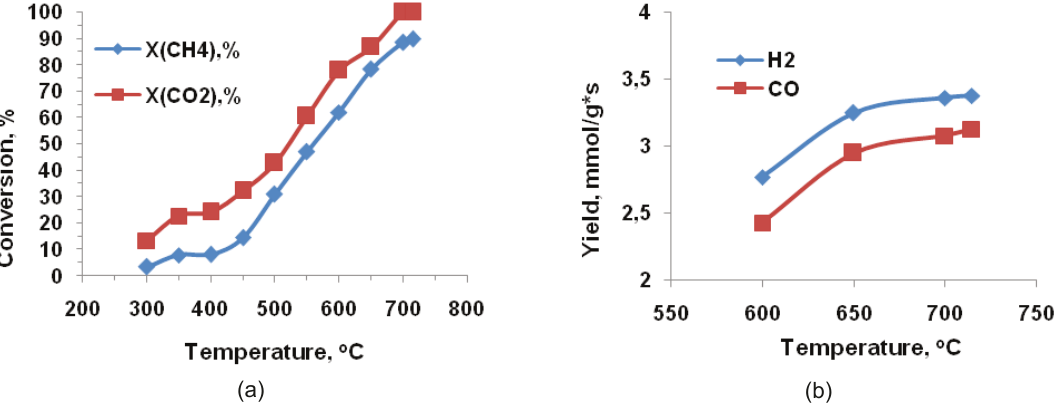
Figure 4. Effect of temperature on the dry reforming of biogas over the 5%(Co-M